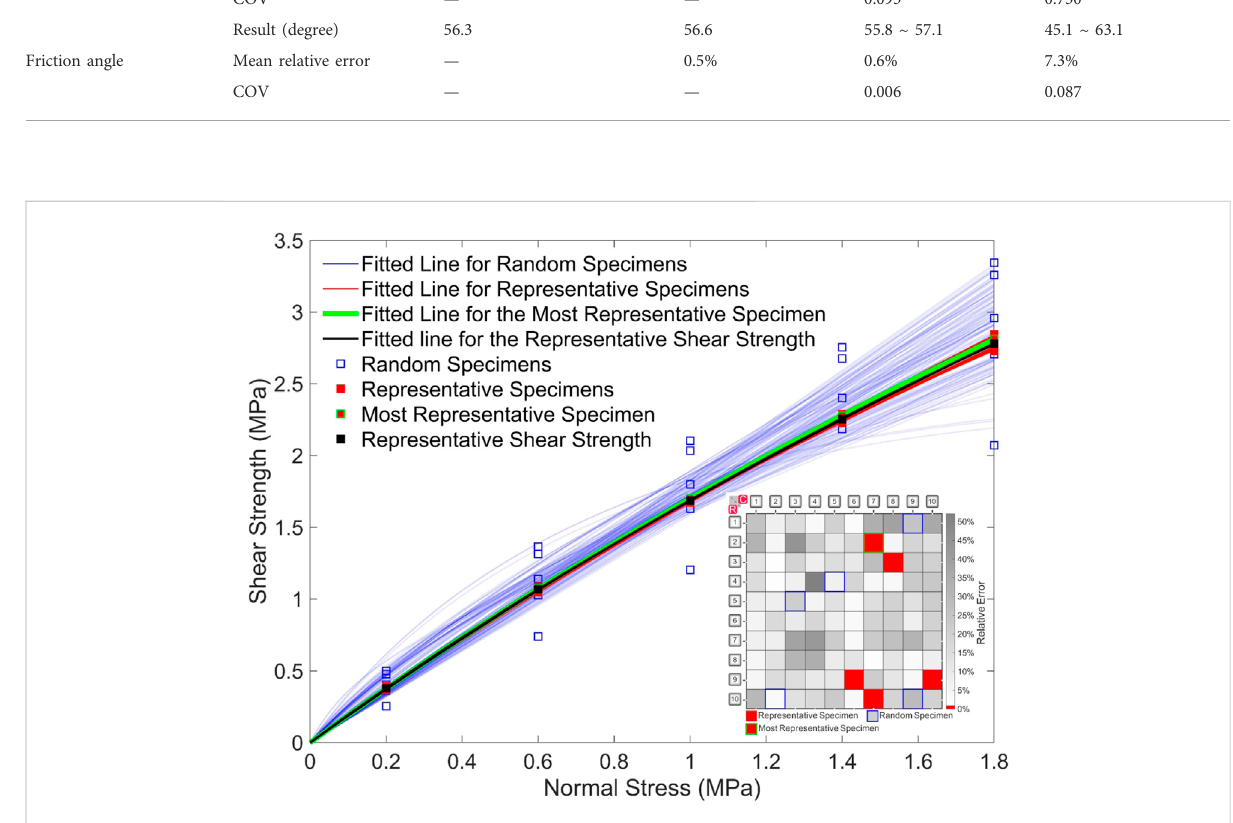
FIGURE 14 Nonlinear shear strength envelopes determined with different